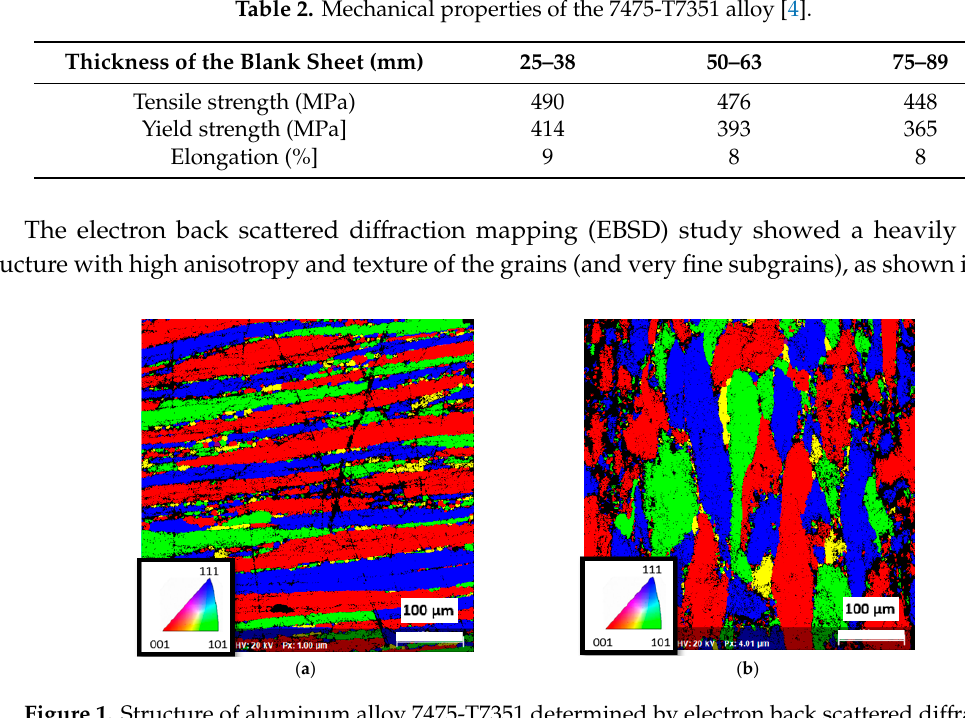
Figure 1. Structure of aluminum alloy 7475-T7351 determined by electron back scattered diffraction mapping (EBSD): ( a ) Longitudinal direction; ( b ) Transversal direction. mapping (EBSD): ( a ) Longitudinal direction; ( b ) Transversal